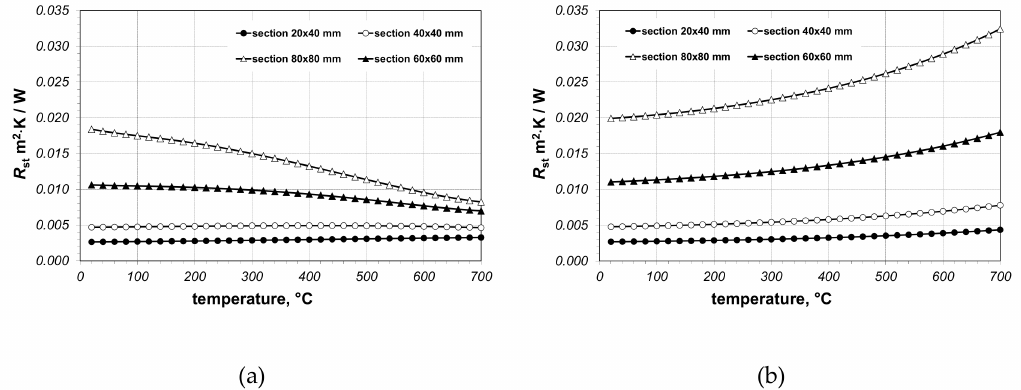
Figure 8. The results of the calculations of R st resistance of sections: ( a ) the values obtained for all kinds of heat transfer and ( b ) values obtained while considering conduction